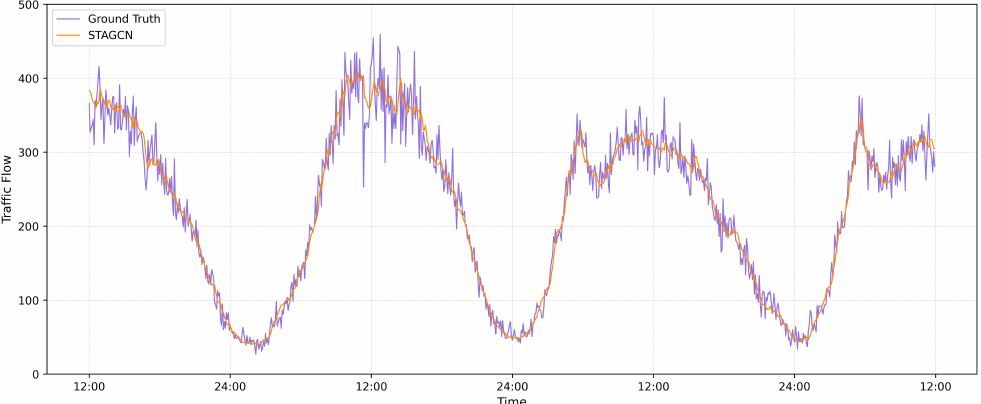
Figure 8. Visualization of the predicted values of traffic flow on the PEMSD8